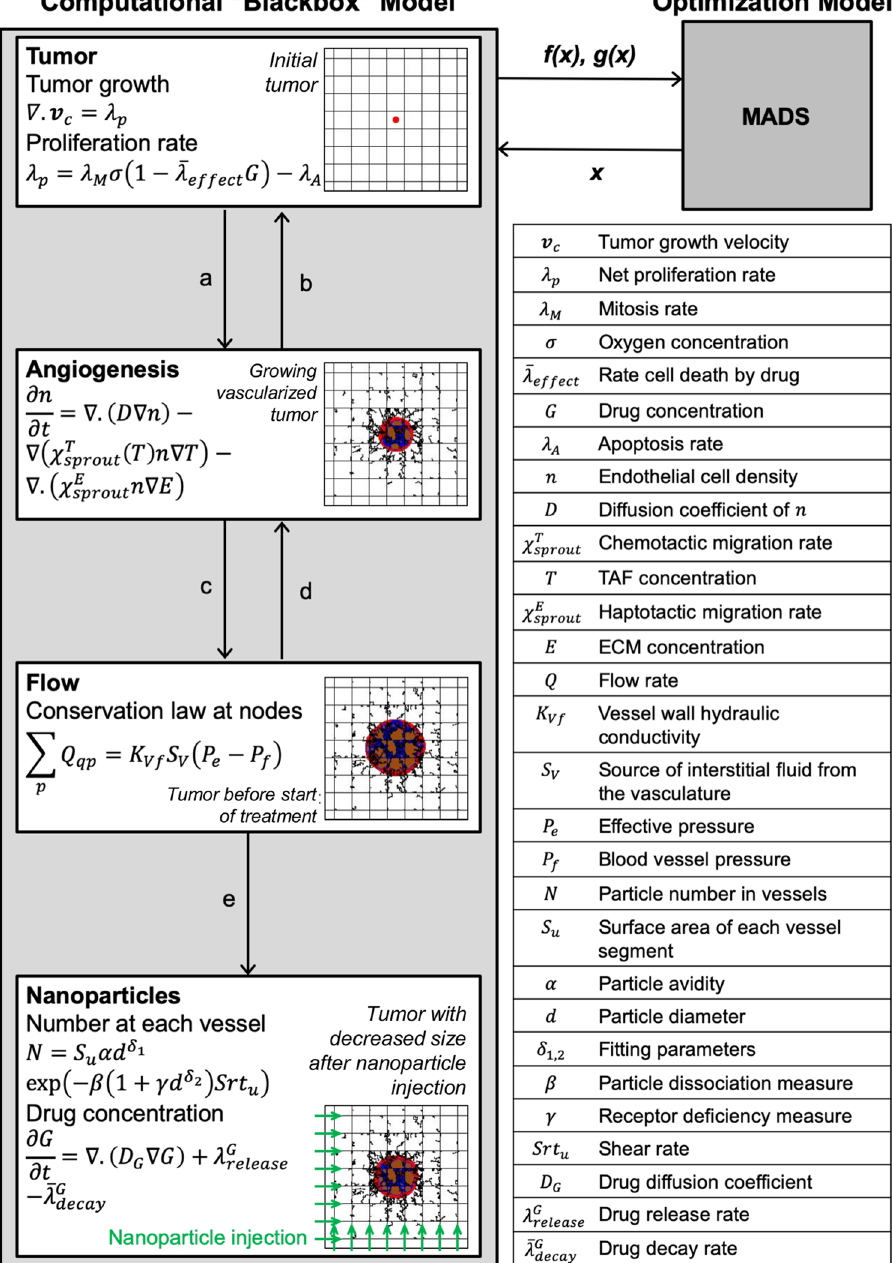
Nanoparticles are injected downstream through the vasculature once the tumor reaches a diameter (760 μ m) sufficient for evaluation of therapeutic effects 7 . The nanoparticles adhere to the tumor vessel walls through ligand-receptor pairs. The success of binding is challenged by blood dissociative forces. The percent accumulation